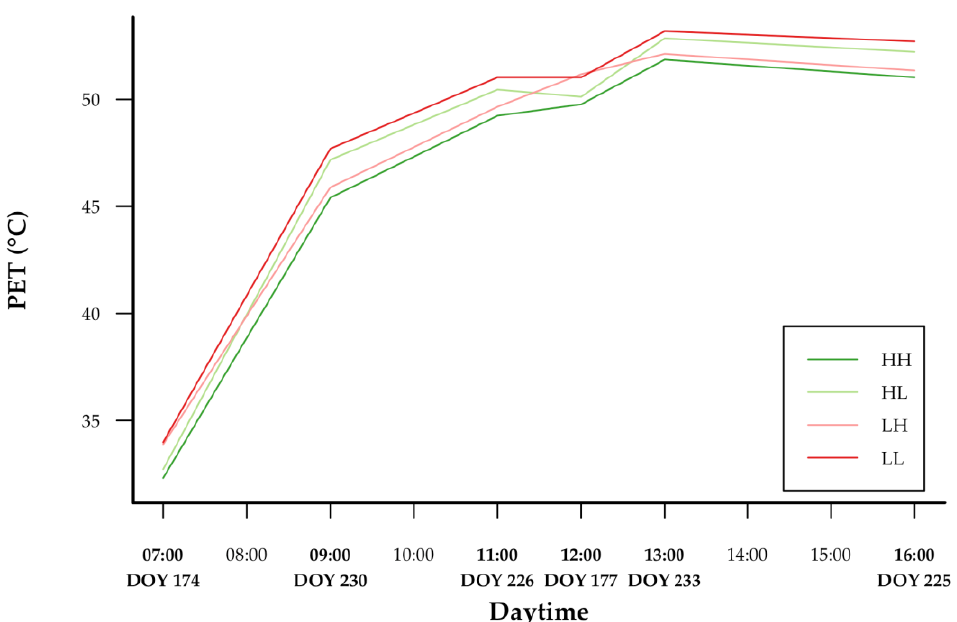
Figure 11. Mean PET values at different daytimes for the four types of crops. DOY indicates at which day in 2021 the ECOSTRESS scene was acquired for the calculation of hUHTI used for PET spatialization over the whole study area.